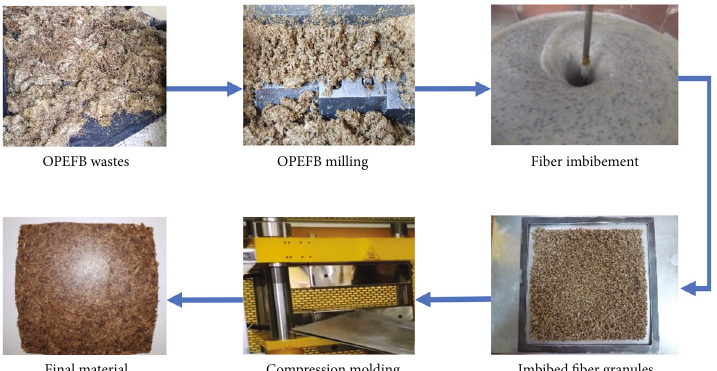
Figure 1: Experimental setup used for OPEFB/acrylic thermoplastic composite elaboration.